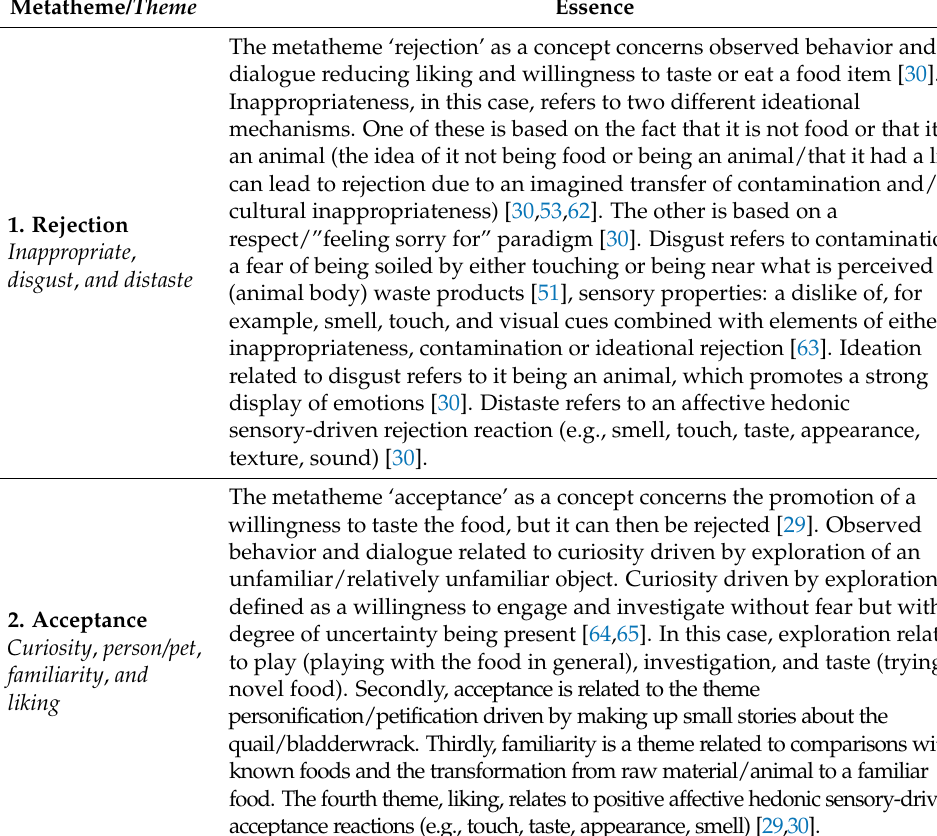
Table A2. Meta-theme and theme